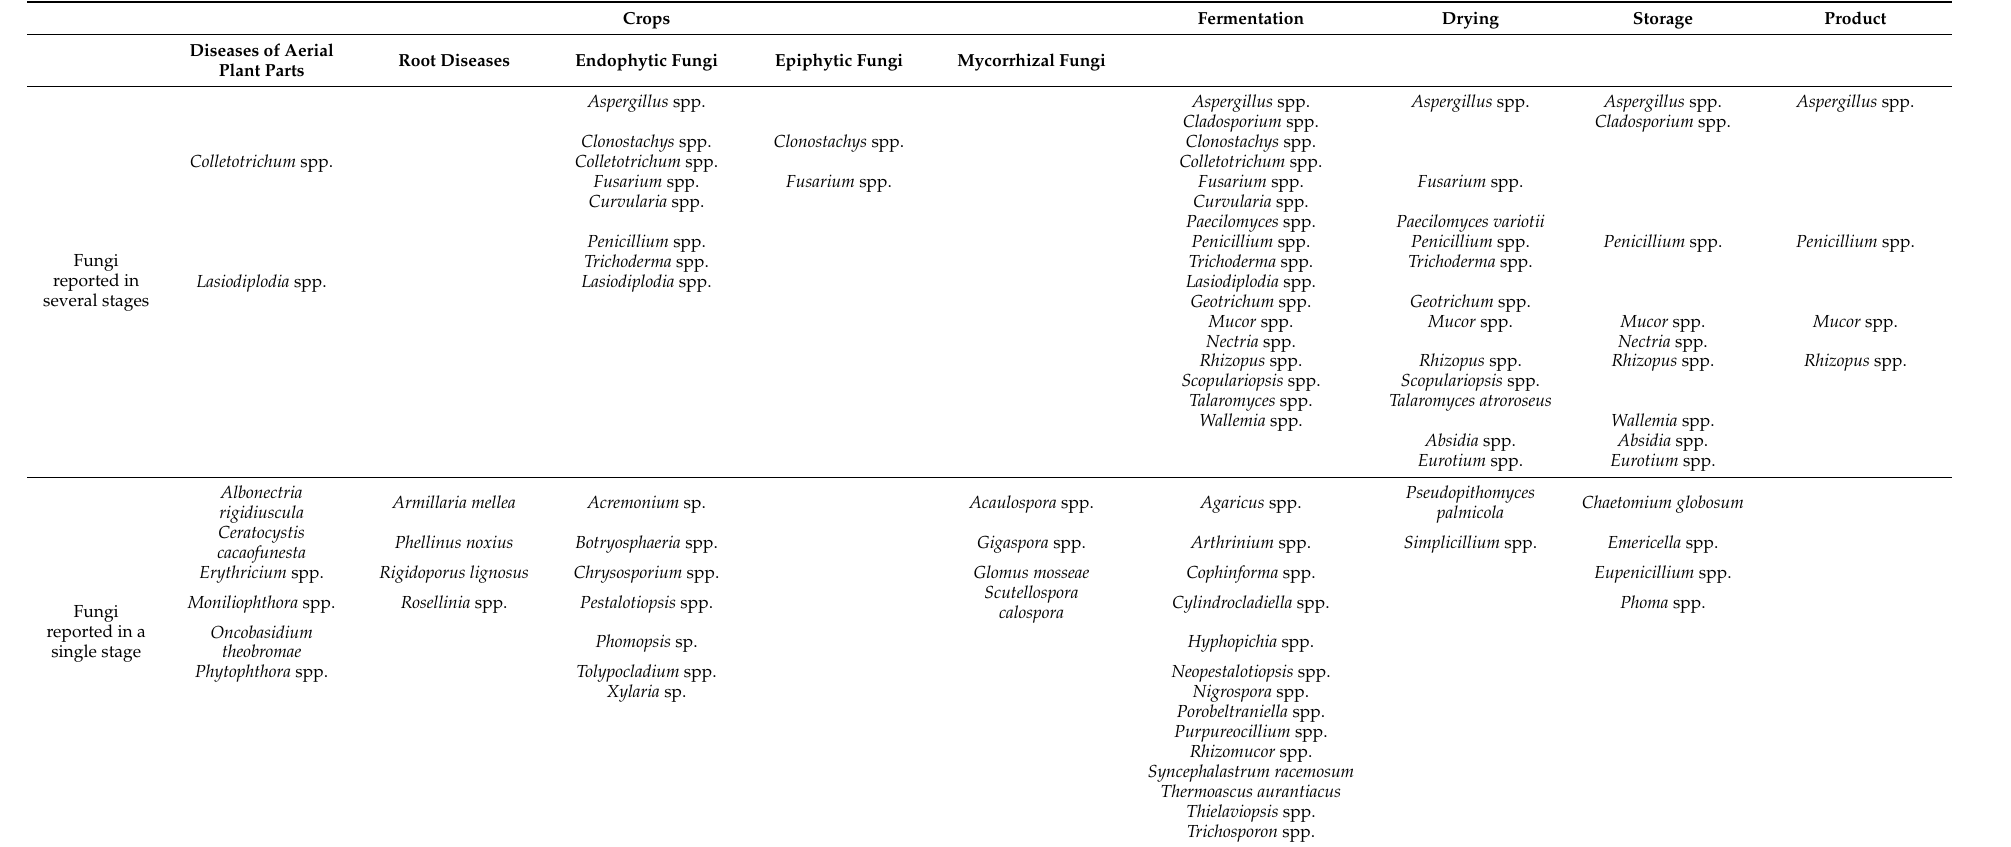
Table 2. Summary of the genera reported of fungi involved in the different stages of cocoa